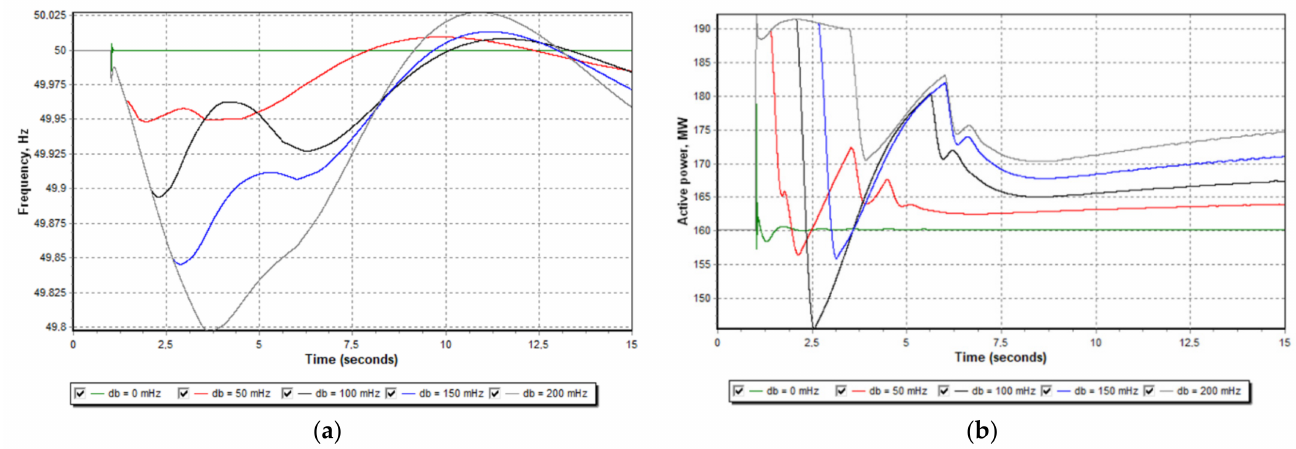
Figure 22. ( a ) Frequency change when the HVDC BtB converter has a different frequency insensitivity range. ( b ) Response of the active power of the HVDC BtB converter to insufficient